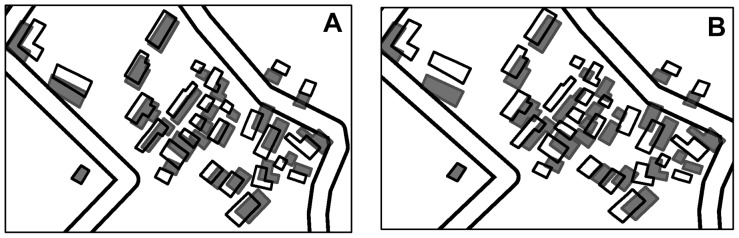
Comparative test on partition B4.(A) r
max = 0.5 mm and (B) r
max = 1.0 mm.